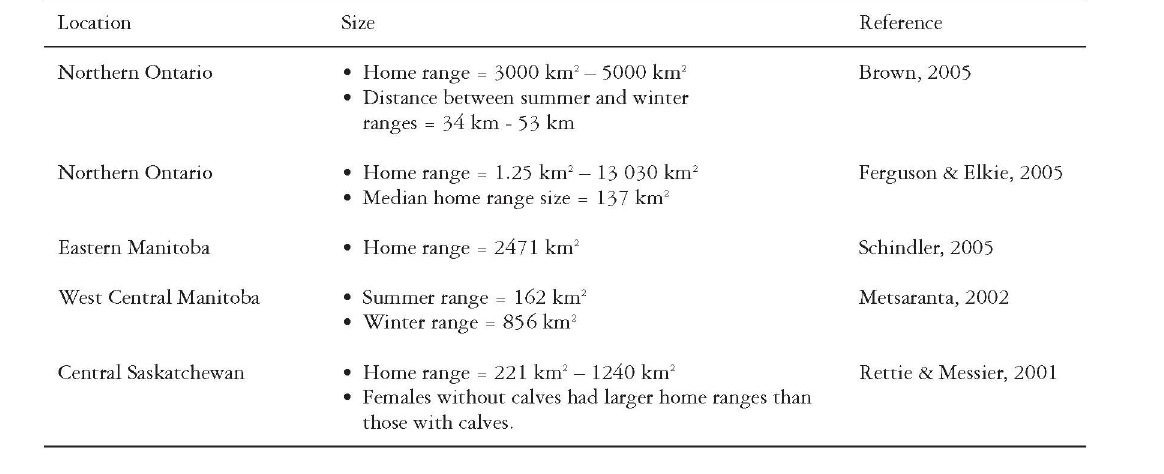
Table 1. Existing annual and seasonal home range estimates in Ontario, Manitoba and